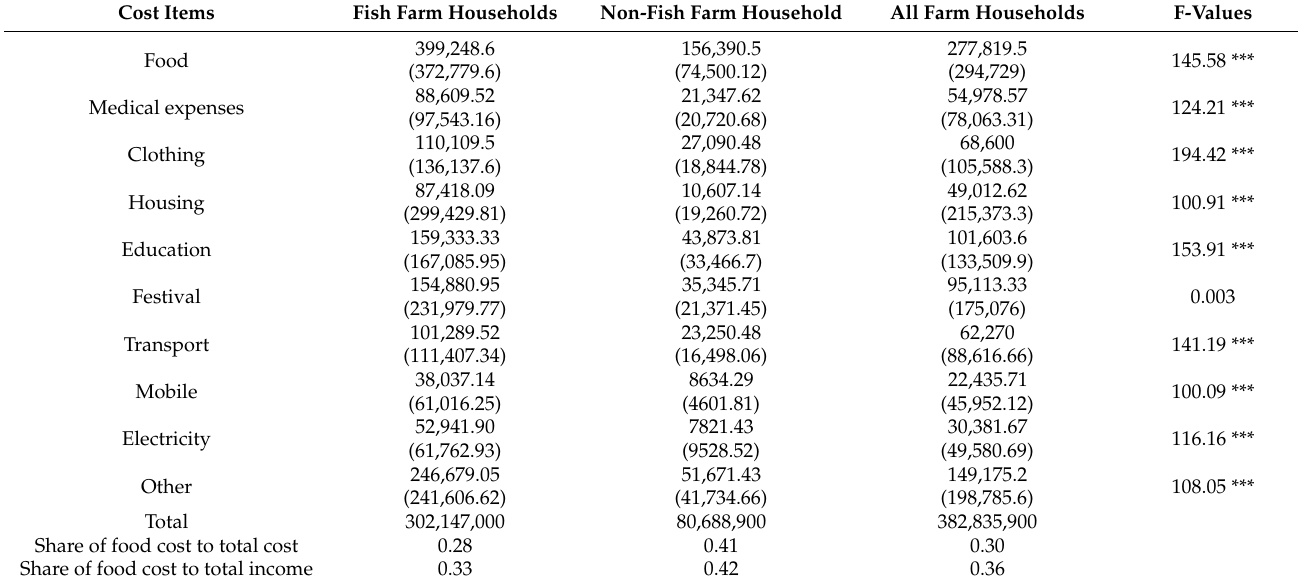
Table 3. Annual households’ expenditure of different items (in Bangladeshi currency, BDT) in 2020.